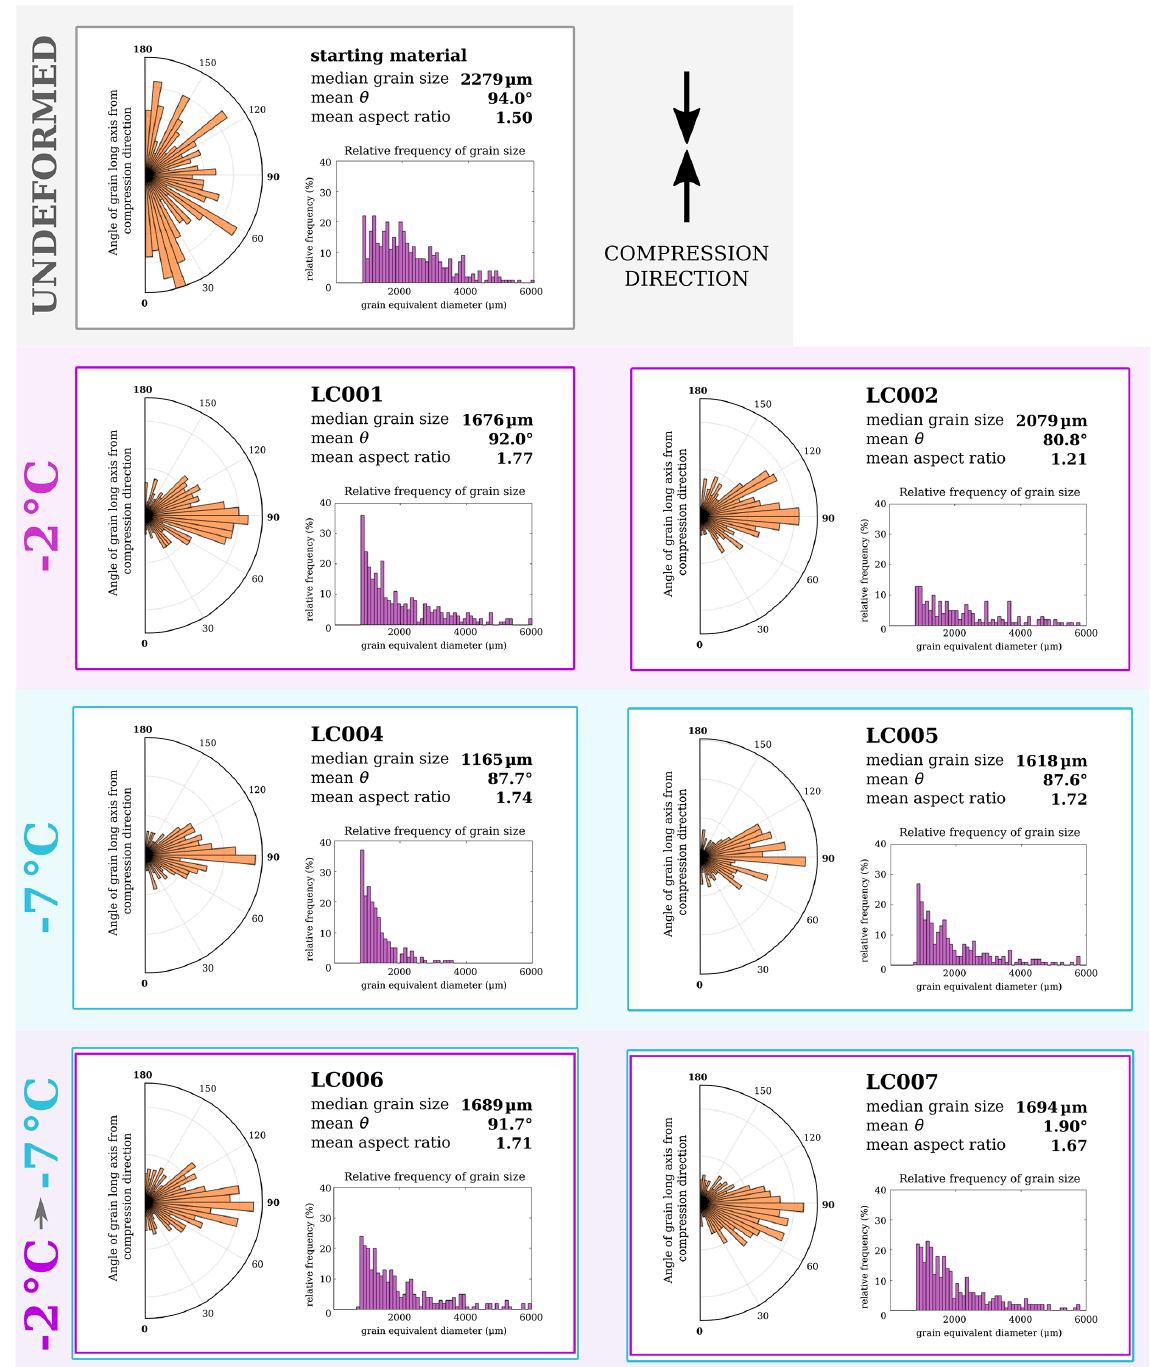
Figure B1. Polar histogram of grain orientations (angle of grain long axis from compression direction), histograms of grain size distribution (measured as grain equivalent diameter), and median values for all samples in set